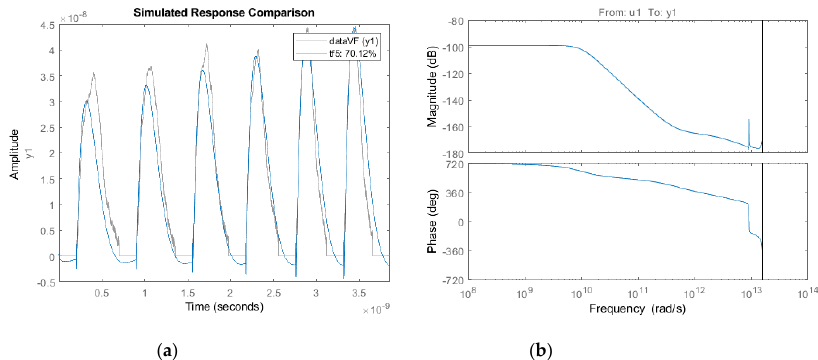
Figure 10. System dynamics response comparison and bode diagram. ( a ) Best fit of the system identification. In this figure, the estimated mathematical model and the real recorded data are illustrated in the same coordinate. This shows that the system behaviour and dynamics in both are